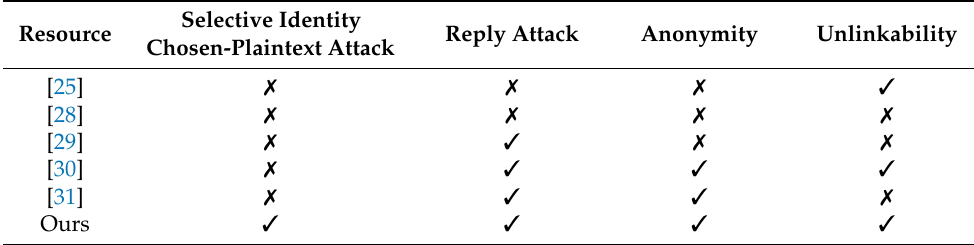
Table 3. Comparison of security